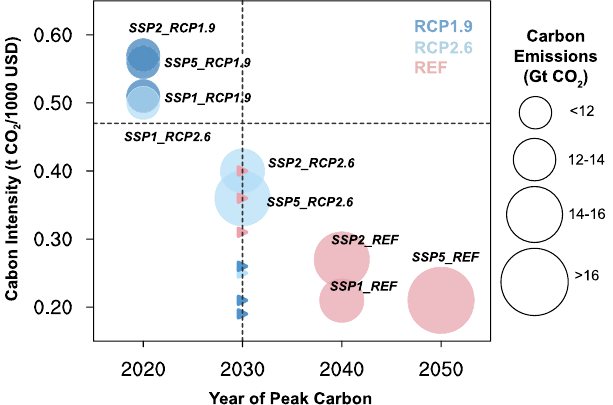
Fig. 2 Years of peak carbon emissions and the carbon intensity in both peak years and 2030 for all nine scenarios. The size of the circles represents the total carbon emissions, and their centers correspond to the year of peak carbon and the value of carbon intensity in that year. Note that the model results of peak years from GCAM here are at 10-year intervals. REF, RCP2.6, and RCP1.9 are marked in pink, light blue and blue, respectively. The two dashed lines represent China ’ s NDC targets of peak year of 2030 and carbon intensity by 2030 (i.e., 0.47t-CO 2 /1000 USD). The carbon intensity in 2030 for the 7 scenarios peaking earlier or later than that year are marked by triangles.